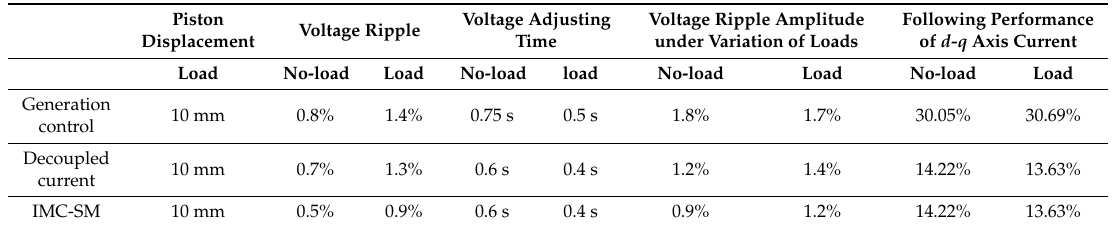
Table 2. Simulation results comparison of three control strategies.